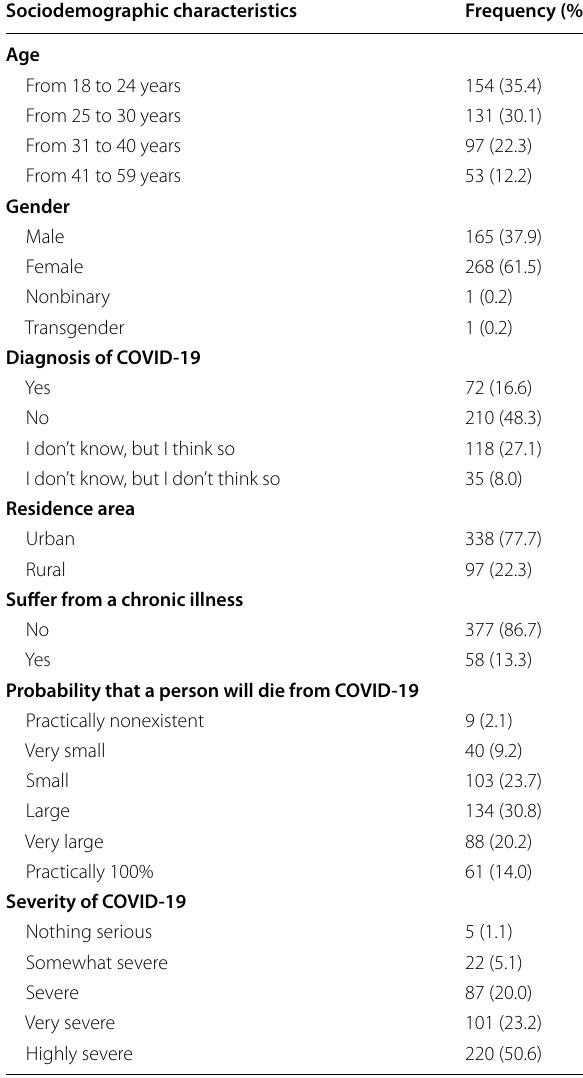
Table 1 Sociodemographic characteristics of the sample ( n =